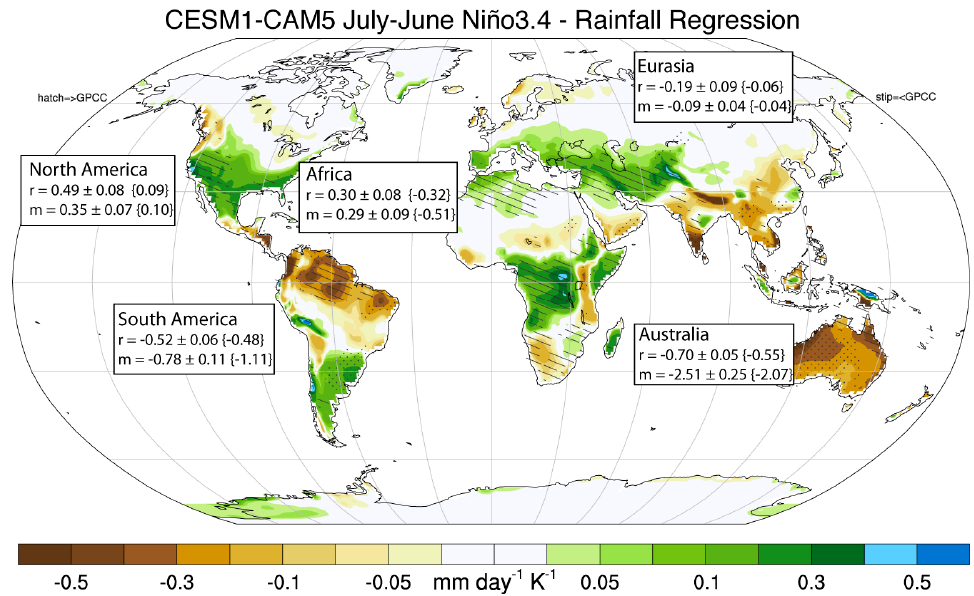
Figure 1. Regressions of CESM regional July through June rainfall anomalies against Niño3.4 SST are shown. Stippled (hatched) regions correspond to locations where regressions derived from HADISST/GPCC are greater (less) than the LE range and |r| > 0.3. Bulk regressions by continent with the σ range of ensemble members are also shown.